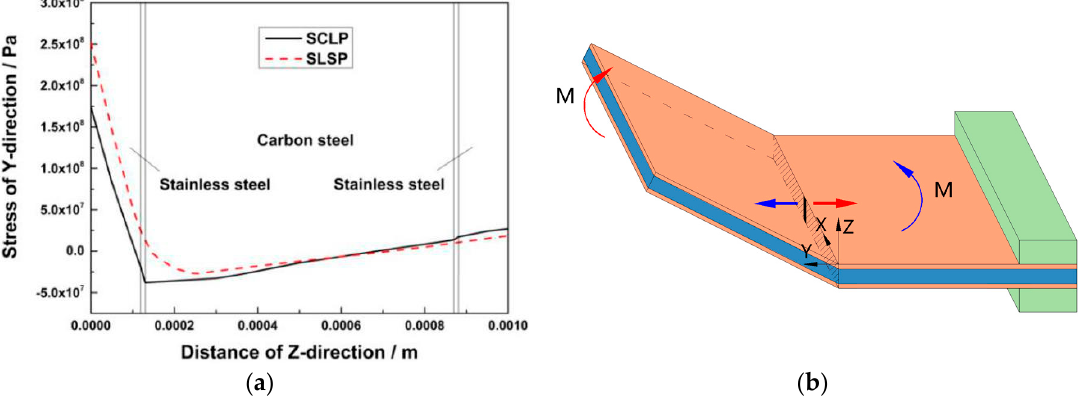
Figure 9. Y-direction stress analysis at 100 s: ( a ) Comparison of stress curves between the SCLP and the SLSP; ( b ) schematic diagram of SCLP bending.